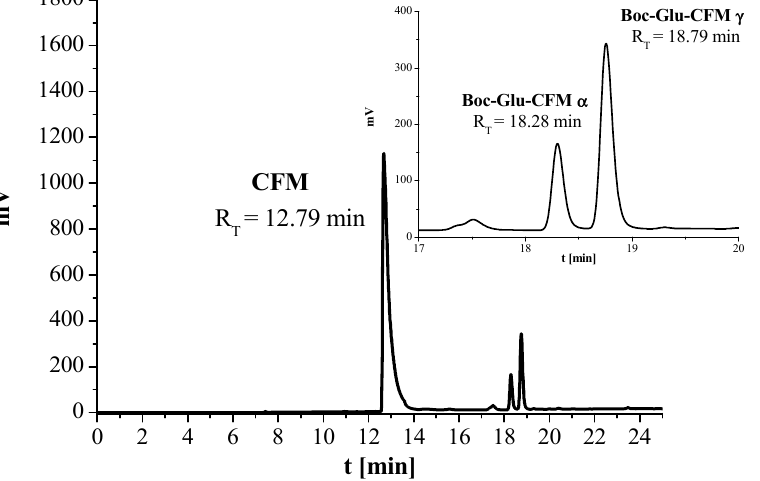
Figure 5. HPLC chromatogram (at 270 nm) of the reaction mixture of Boc-Glu-CFM derivative synthesis: Boc-Glu-CFM( α ) (R T = 18.28 min) and Boc-Glu-CFM( γ ) (R T = 18.79 min) (gradient 2).